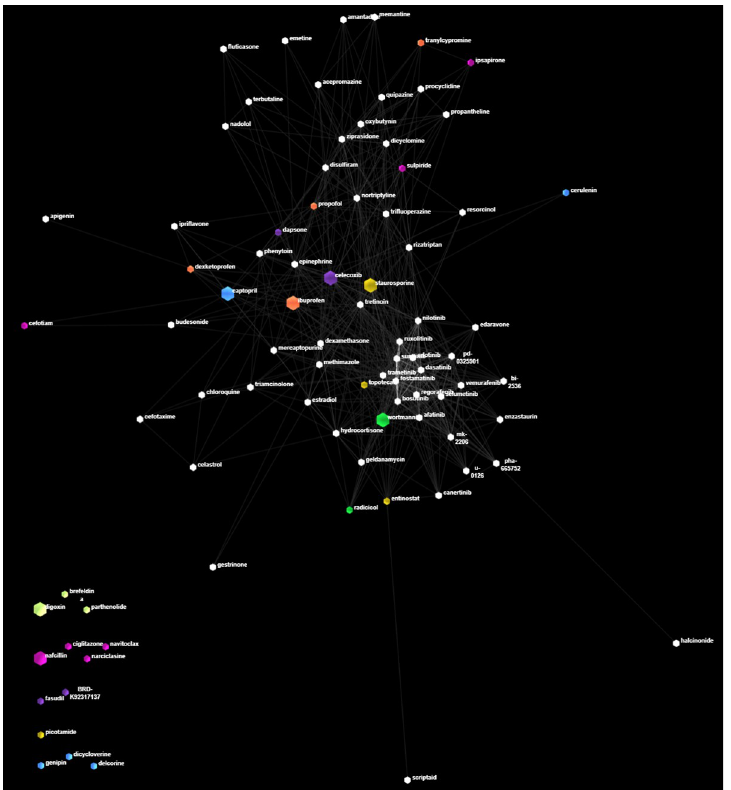
Fig 8. Functional and structural relations among highlighted drugs relative to the PathWalks highlighted pathways. In this network, structurally similar nodes are painted in the same color. Edge weights and proximity of nodes are proportional to the number of their common gene targets that participate in all top-highlighted pathways. The top-7 repurposed drug candidates are scaled-up. On the bottom left corner of this figure, we have added any of the top-7 drugs that did not share gene targets with the rest of the candidates, as well as nodes that belong in any of these 7 respective structural clusters. Drugs that do not share gene targets in the highlighted pathways and that do not belong in any of the 7 highlighted structural groups are not showing in this network. We observe that some co-clustered drugs are also functionally similar to the discussed drugs, such as wortmannin and radicicol (green) and the triplet ibuprofen, dexketoprofen and propofol